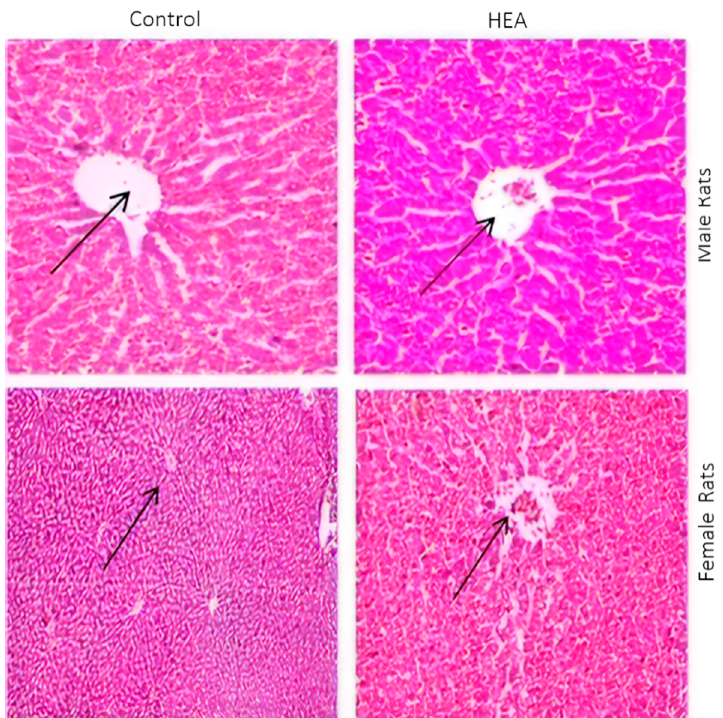
Figure 7. Histopathological examination of H&E stained sections of liver of male and female albino rats administered 2500 mg/kg body weight of HEA as compared to control (0 mg/kg body weight) using 1200× magnification power.